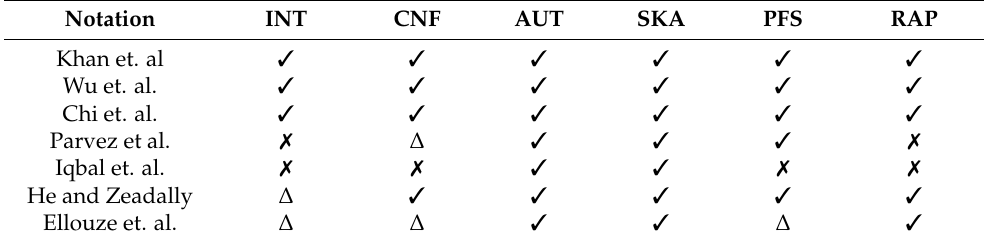
Table 3. Comparison by security strength.